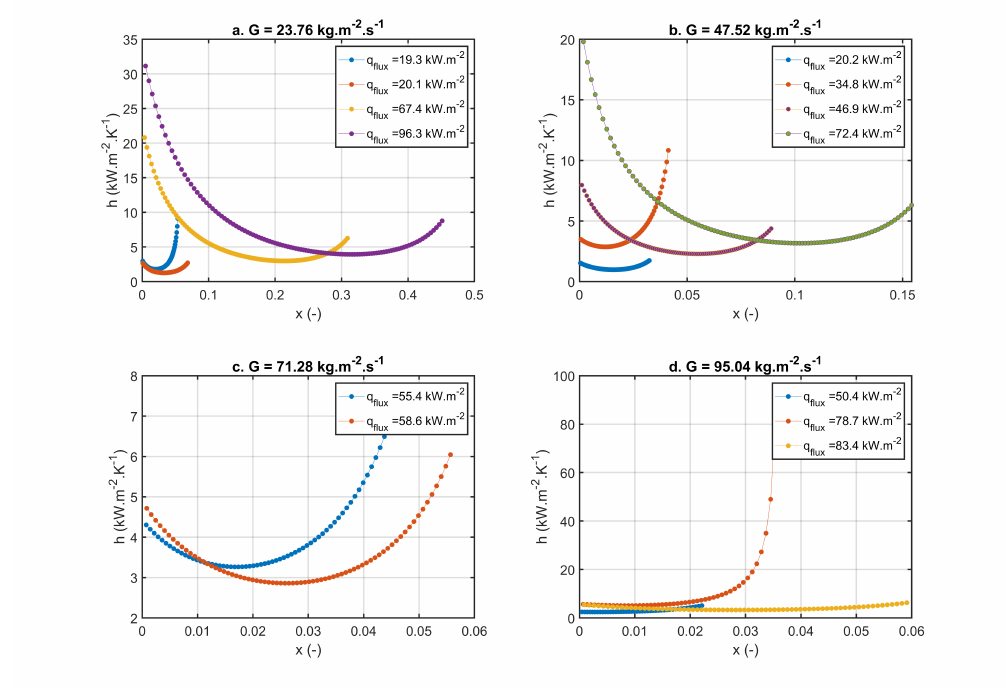
Figure 10. Local boiling heat transfer coefficient vs. vapor quality for channel 2 with fixed mass flux in each subplot for channel 1.05 mm ˆ 0.5 mm ( D h = 677 µ m). ( a ) G = 23.76 kg ¨ m ´ 2 ¨ s ´